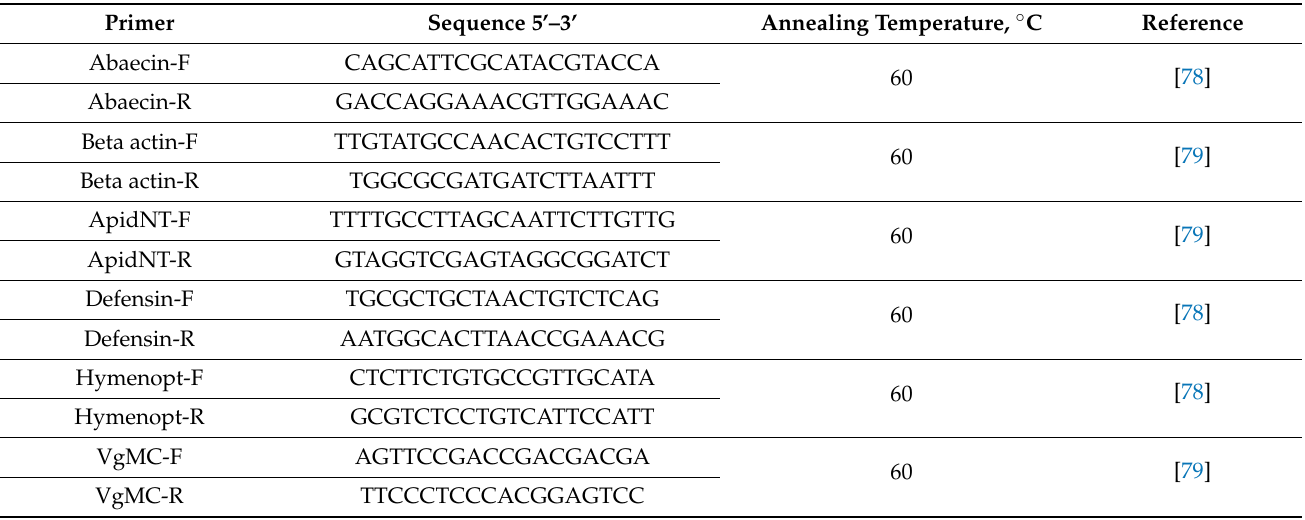
Table 2. Primer pairs used for qPCR